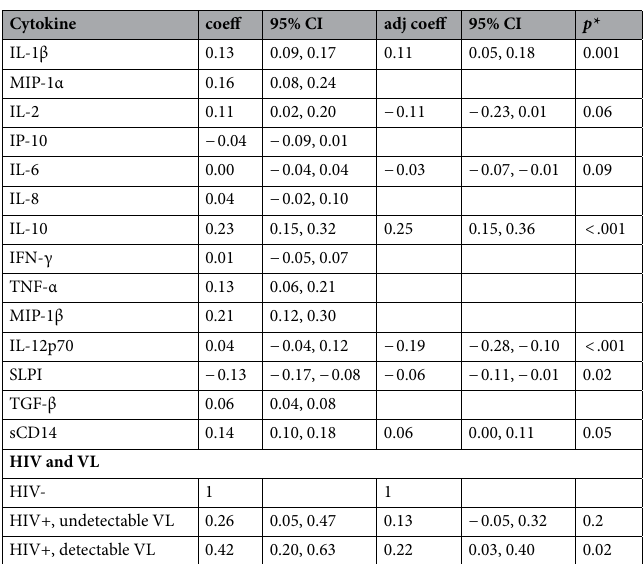
Table 3. Shannon Diversity Index by log vaginal cytokine concentrations at 16–20 gestational weeks, N = 206. Coefficients, 95% confidence intervals, and associated p values calculated by linear regression.